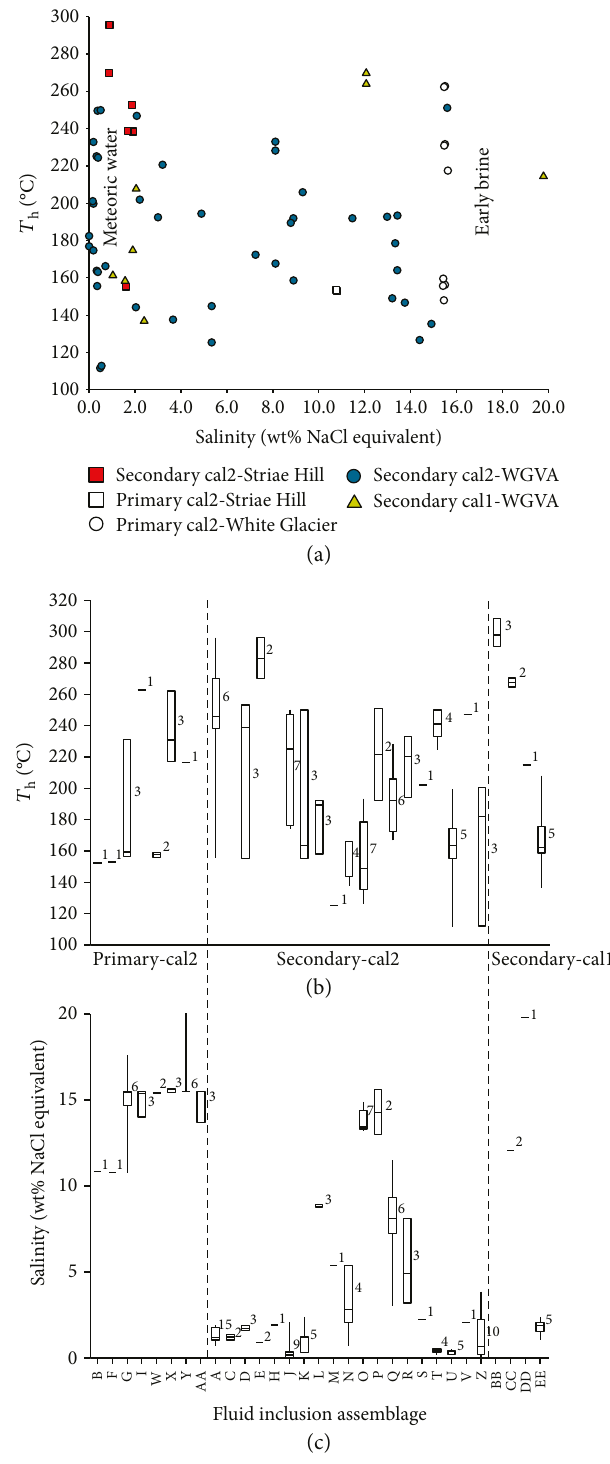
Figure 10: Microthermometric data for primary and secondary fl uid inclusions in carbonates from the paleosprings (WGVA and Striae Hill vs. bulk salinity) for primary and secondary inclusions in carbonates from WGVA and Striae Hill sites). (a) Summary of all data ( T h